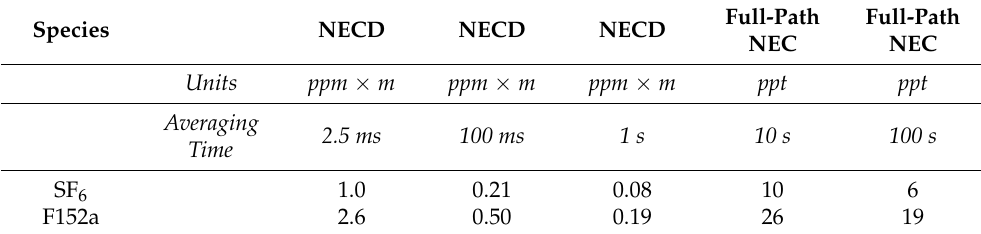
Table 1. Summary of Allan deviation analysis for the swept-ECQCL standoff detection system. The noise-equivalent column density (NECD) for each species is tabulated for various averaging times. Noise-equivalent concentrations (NEC) are calculated assuming each species fills the entire 3000 m measurement